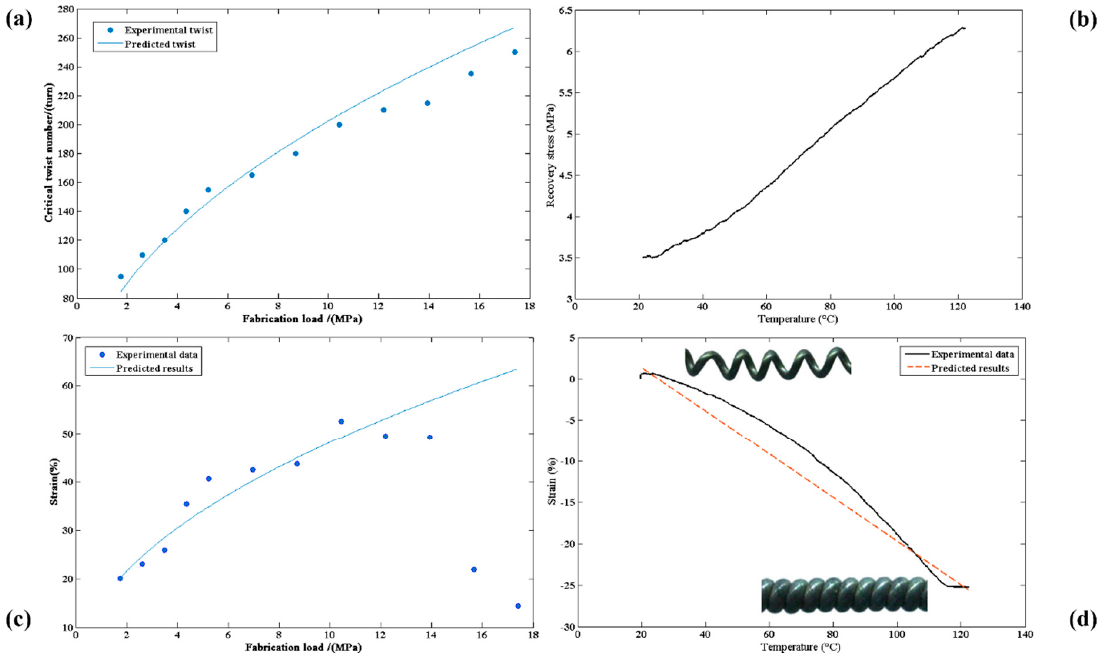
Figure 2. Performance of the TCP muscles ( a ) critical twist number of Nylon 6 fiber from different fabrication load; ( b ) recovery stress curve of a TCP muscle with 3.48 MPa fabrication load at constant strain of 30%; ( c ) maximum strain of TCP muscles from different fabrication load; and ( d ) recovery strain curve of a TCP muscle with 3.48 MPa fabrication load at constant tensile force of 0.8 N.